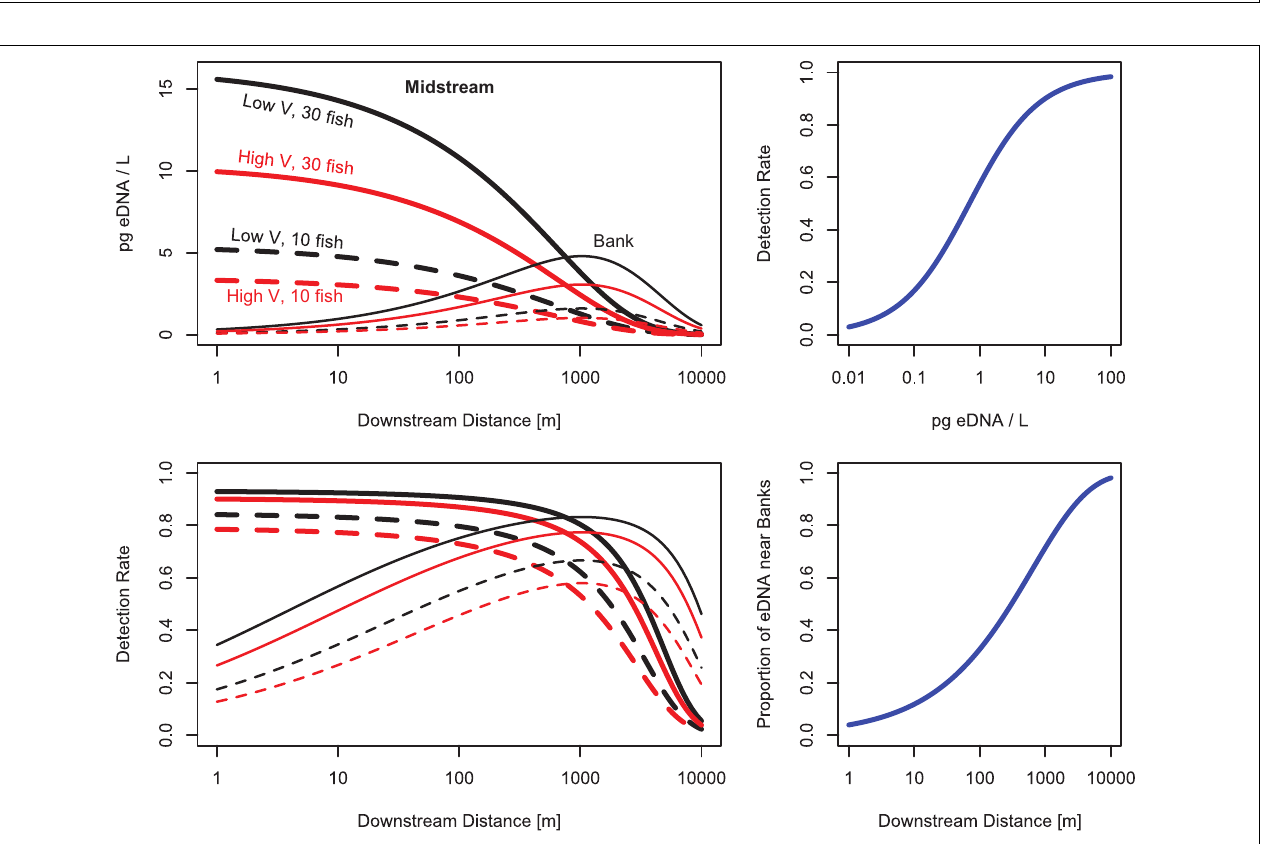
FIGURE 4 | Modeled salmon eDNA quantities and detection rates downstream from fish. Top left: eDNA is most abundant near the fish, then disperses to the banks, where eDNA is most abundant roughly 1,000 m downstream from the fish. Values shown are predicted values for an average stream. Top right: after roughly 1,000 m, more eDNA can be found in bankside samples than midstream samples. Bottom left: Midstream samples have higher detection rates near the fish, while bankside samples have higher detection rates roughly 1,000 m downstream from the fish. Bottom right: eDNA detection rates are greater than 50% when predicted eDNA concentrations are > 1 pg/L; eDNA detection rates are roughly 90% when predicted eDNA concentrations are > 10 pg/L.